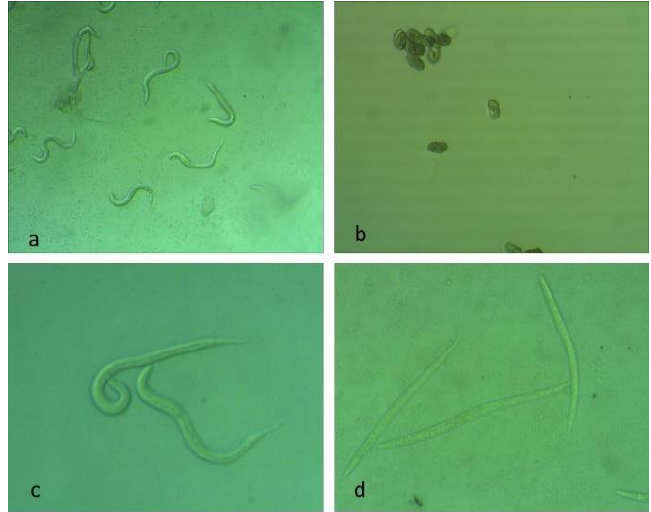
Figure 5. Microscopic images (Nematicidal assay) of C. elegans. The hatch inhibition assays of C. elegans eggs without ACF (( a ). control) and with ACF (( b ). test) were conducted and a number of unhatched eggs and hatched larvae were observed and counted under optical microscope after 24 h of incubation. Mortality assay of C. elegans L1 larvae without ACF (( c ). control) and with ACF (( d ). test) were conducted. After incubation for 24 h, L1 were observed and judged as dead if their body was straight without movement as compared to control.